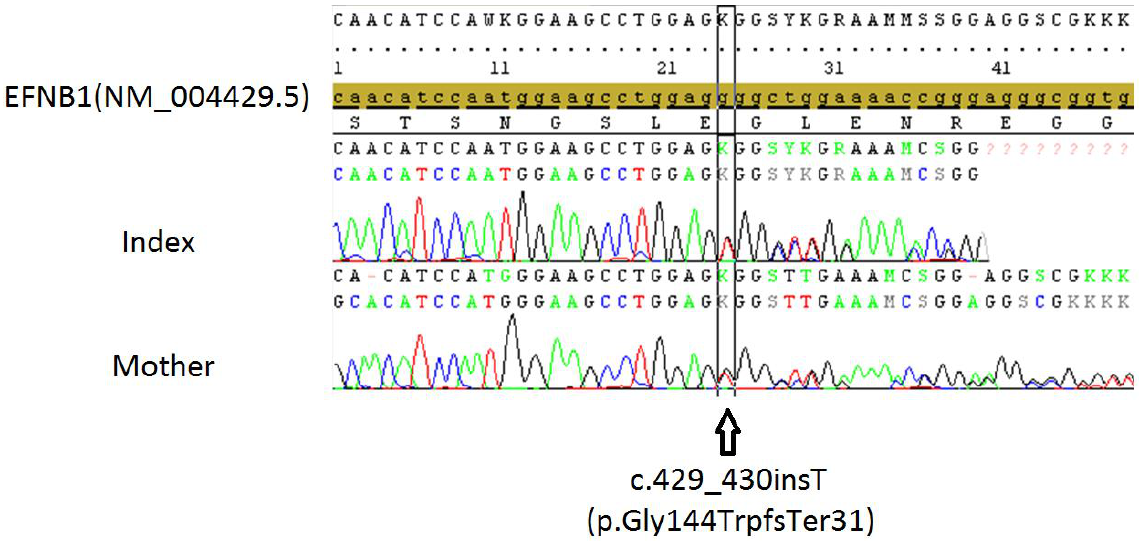
Figure 4. EFNB1 gene sanger sequencing of the patient (index) and her mother. The sequencing of the EFNB1 gene revealed c.429_430insT (p.Gly144TrpfsTer31) heterozygote variant. The variant created an insertion of a T base in the position of 68059530, which caused a frameshift and production of a termination codon after 31 bases.